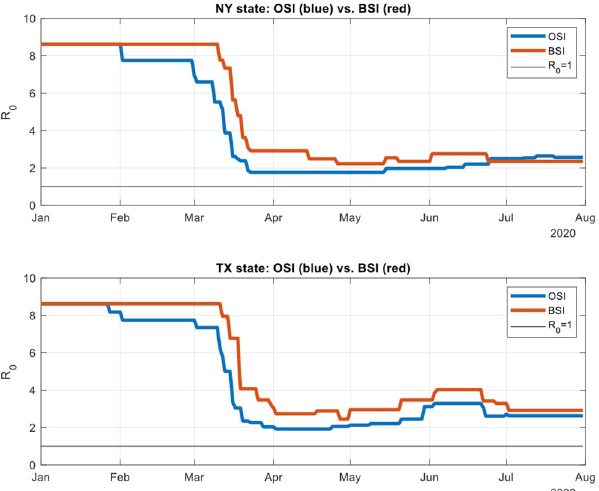
Fig 4. Comparison of Oxford Stringency Index (OSI) and Bentley Stringency Index (BSI). Legend : This graphs shows the simulated R 0 by using New York and Texas as examples. The simulation period was from January to August 2020. The BSI gives a slightly more conservative result than the OSI.